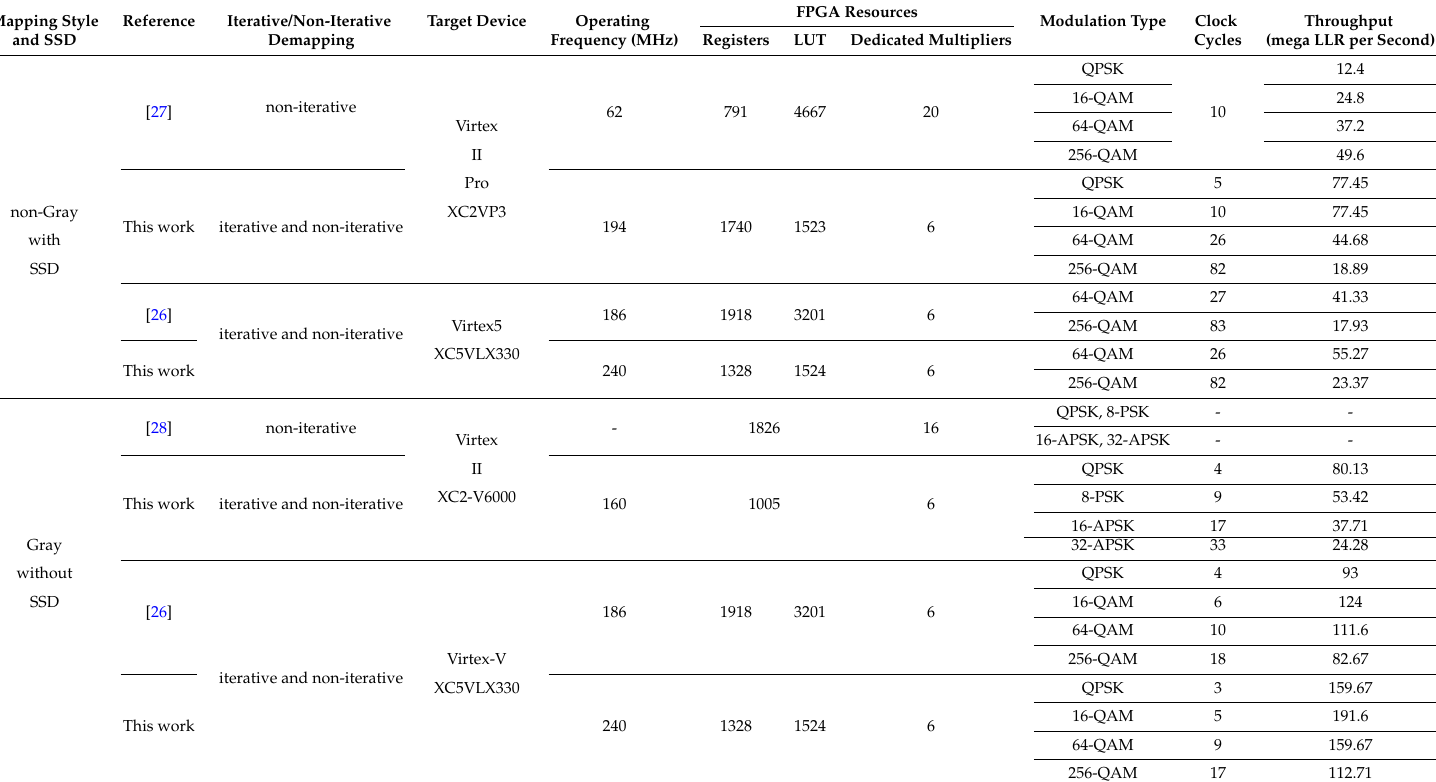
Table 6. Comparison summary of the proposed demapper with the relevant state-of-the-art implementations. SSD, signal space